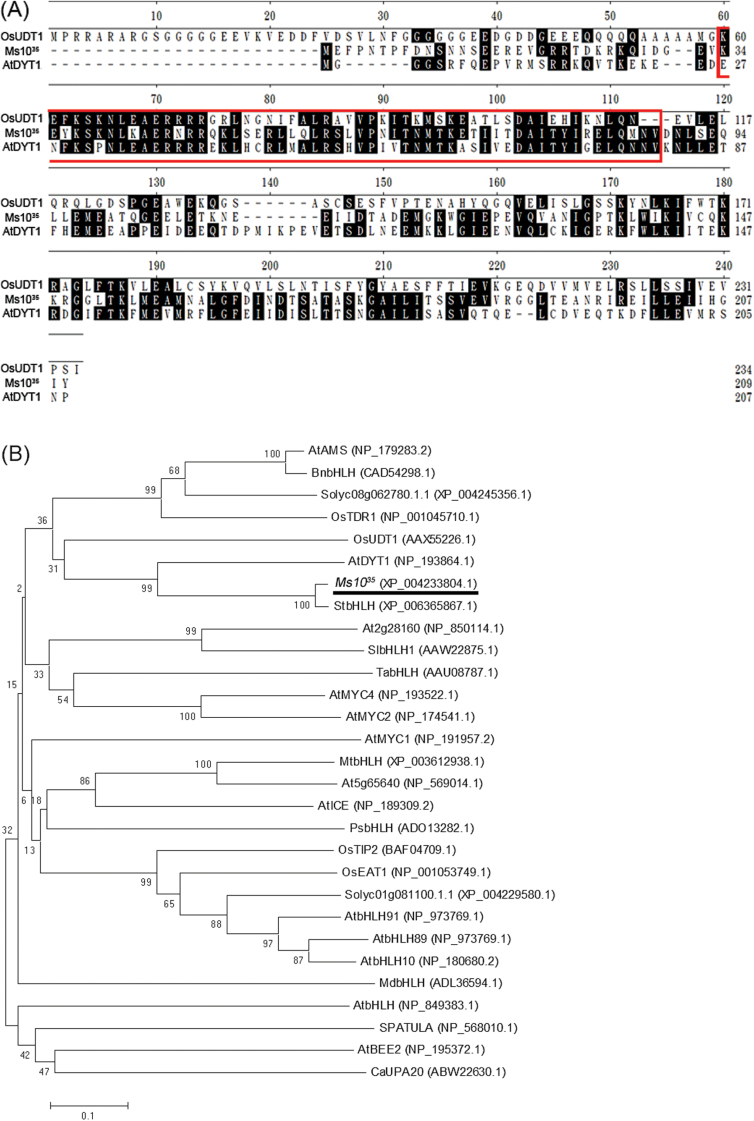
Comparison of Ms1035 and its homologues. (A) Amino acid sequence alignment of Ms1035 and homologous proteins from potato (StbHLH), Arabidopsis (AtDYT1), and rice (OsUDT1). Alignments based on the conserved region of the Ms1035 protein were generated using ClustalW of MegAlign (DNASTAR). The conserved bHLH domain is indicated by the outlined box. Black shading indicates identical residues. (B) Phylogenetic tree of Ms1035 and other bHLH proteins from several plant species. The phylogenetic tree of deduced amino acid sequences was generated with the neighbour-joining method using MEGA5 software (http://www.megasoftware.net). Bootstrap values (%) are from 1000 replicates, indicated above the nodes. Ms1035 is underlined. At, Arabidopsis thaliana; Bn, Brassica napus; Ca, Capsicum annuum; Mt, Medicago truncatula; Md, Malus domestica; Os, Oryza sativa; Ps, Pisum sativum; Sl, Solanum lycopersicum; St, Solanum tuberosum; Ta, Triticum aestivum. GenBank accession numbers are given in parentheses. (This figure is available in colour at JXB online.)